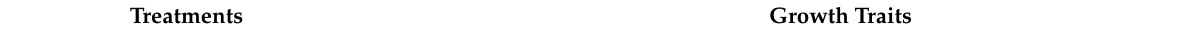
Table 1. Effects of N application on green leaf area, plant height, aboveground dry mass (ADM) and relative growth rate (RGR) of wheat plants under short-term heat, drought and combined stress after